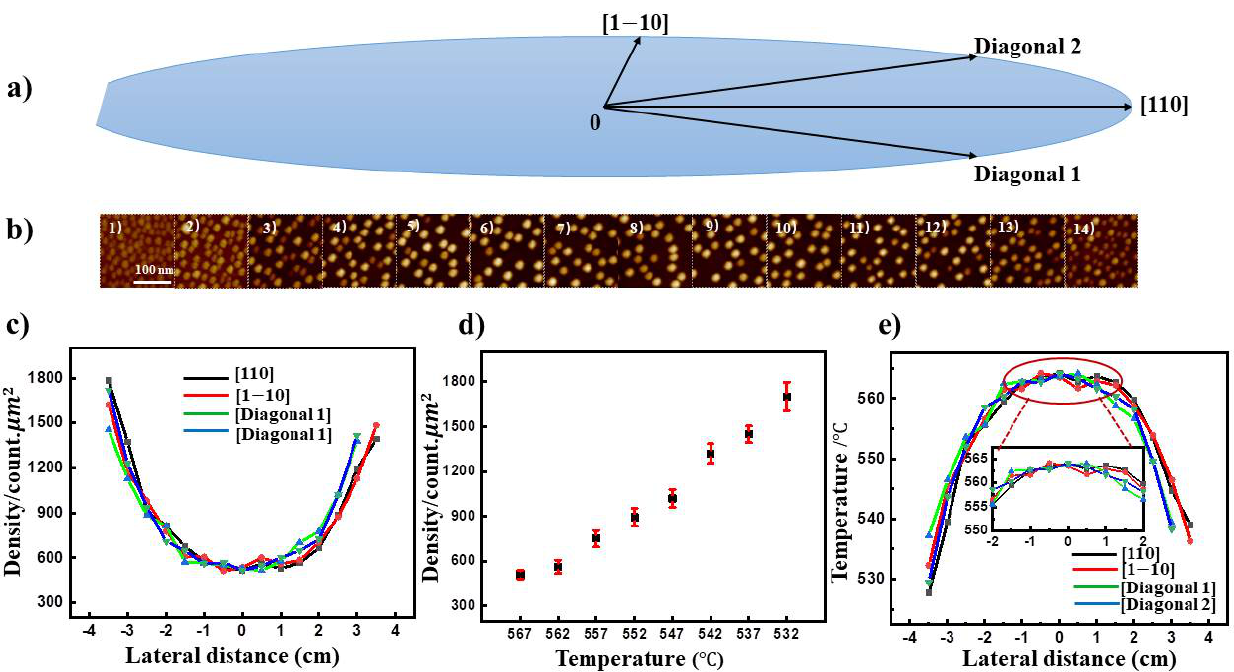
Figure 2. ( a ) three-inch wafer geometric structure: crystallographic directions of [110] and [1–10], diagonal 1 and diagonal 2; 0 represents the geometric center of the wafer, the arrow direction represents the positive direction, respectively. ( b ) Representative AFM results of InAs quantum dots of sample A in [110] crystallographic direction: (1)–(14) from left to right with 5 mm interval distance. ( c ) Density distribution of the four directions of sample A of the whole wafer, black line represents [110], red line represents [1–10], green line represents diagonal 1, blue line represents diagonal 2, respectively. ( d ) The density of quantum dots as a function of substrate temperature with red error bars. ( e ) wafer-scale temperature distribution of three-inch wafer with inset graphics shows small fluctuation of temperature from −2 to 2 cm.